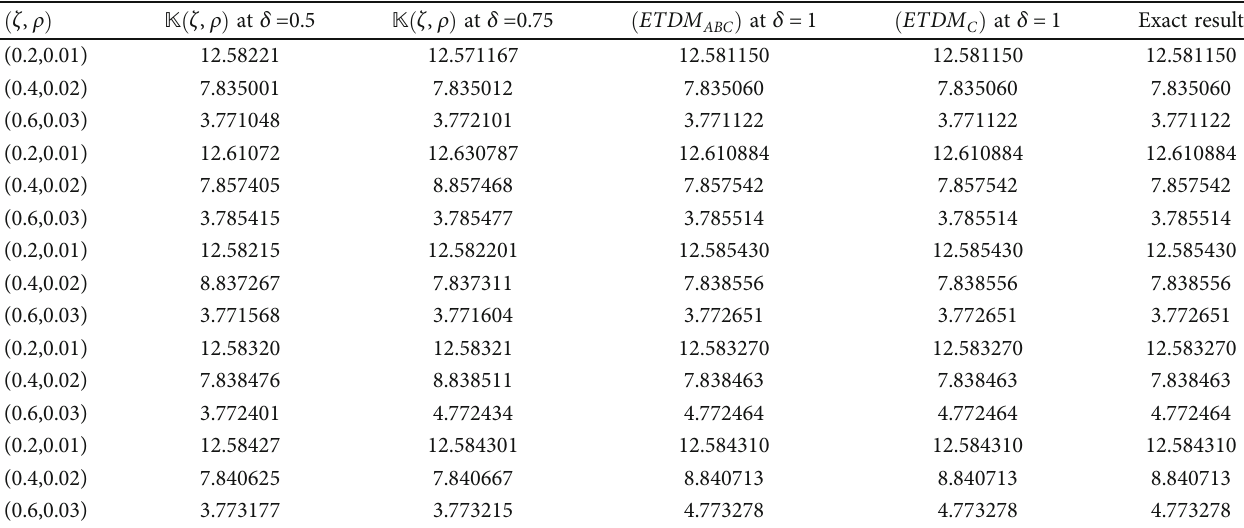
Table 2: Proposed method solution for K ð ζ , ρ Þ at di ff erent fractional orders of problem